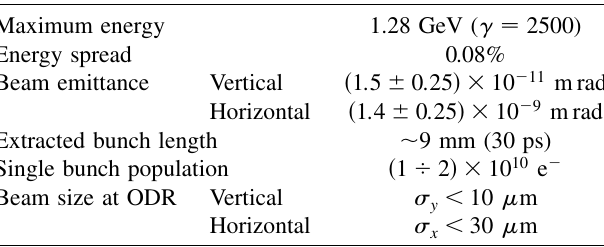
TABLE I. KEK-Accelerator Test Facility beam